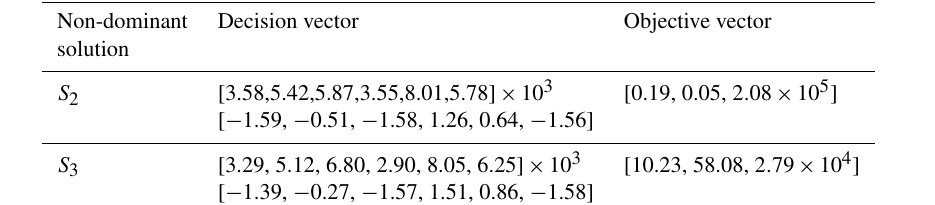
Table 2. Decision vectors and objective vectors of S 2 and S 3 .